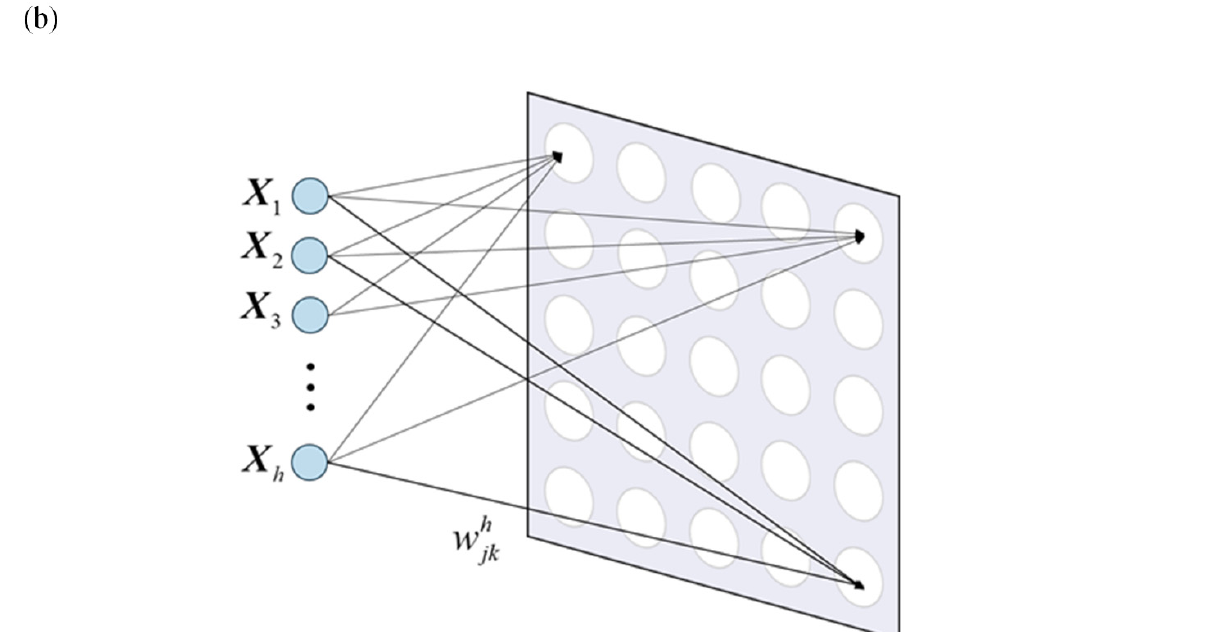
Figure 3. The structures of ( a ) SVM and ( b ) SOM.